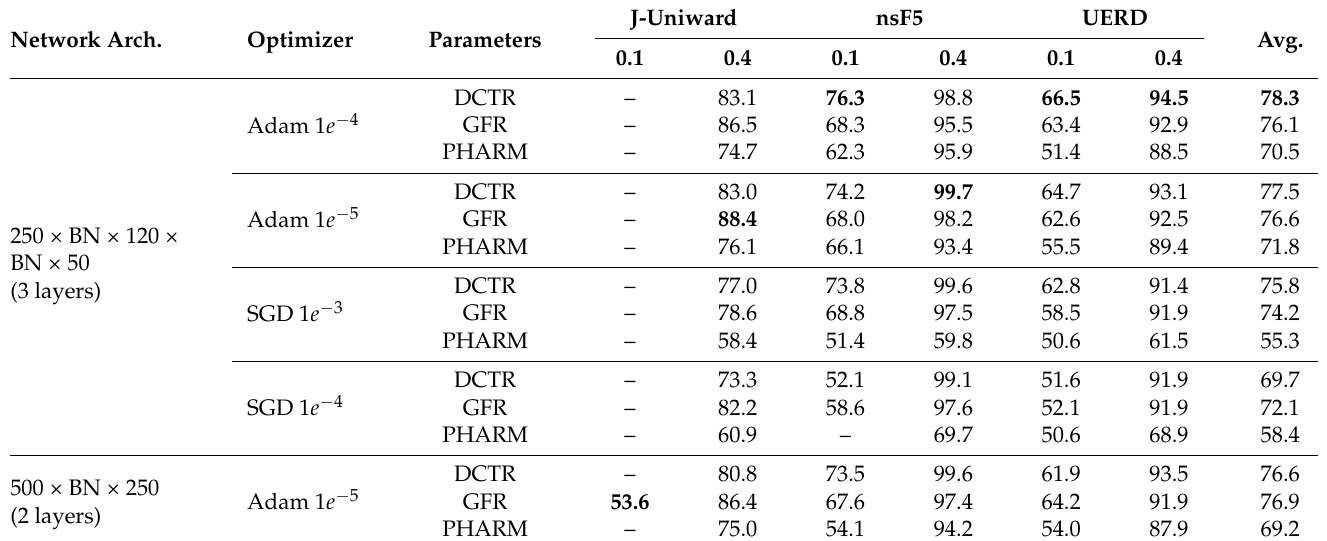
Table 2. Accuracy of image steganography detection (in percentages) for various architectures of neural networks and optimizers. The best values in each column are shown in bold. Network